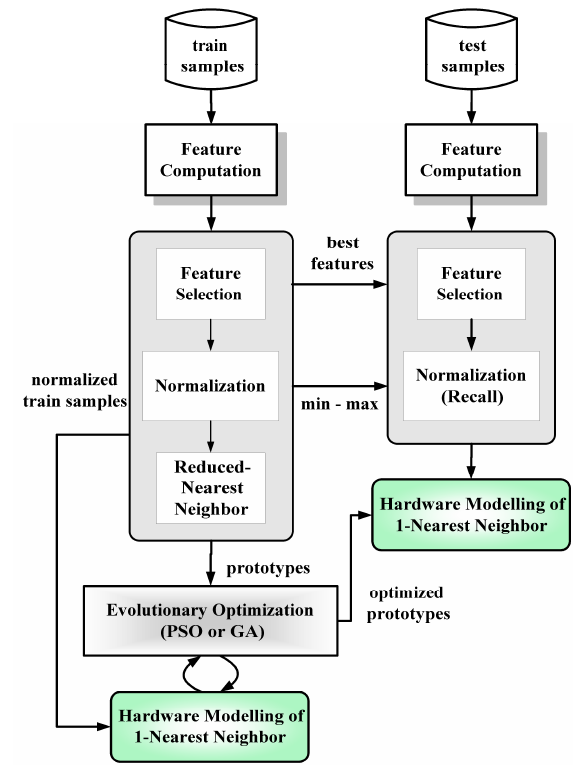
Figure 26. Procedure of the hardware constraint prototype optimization.